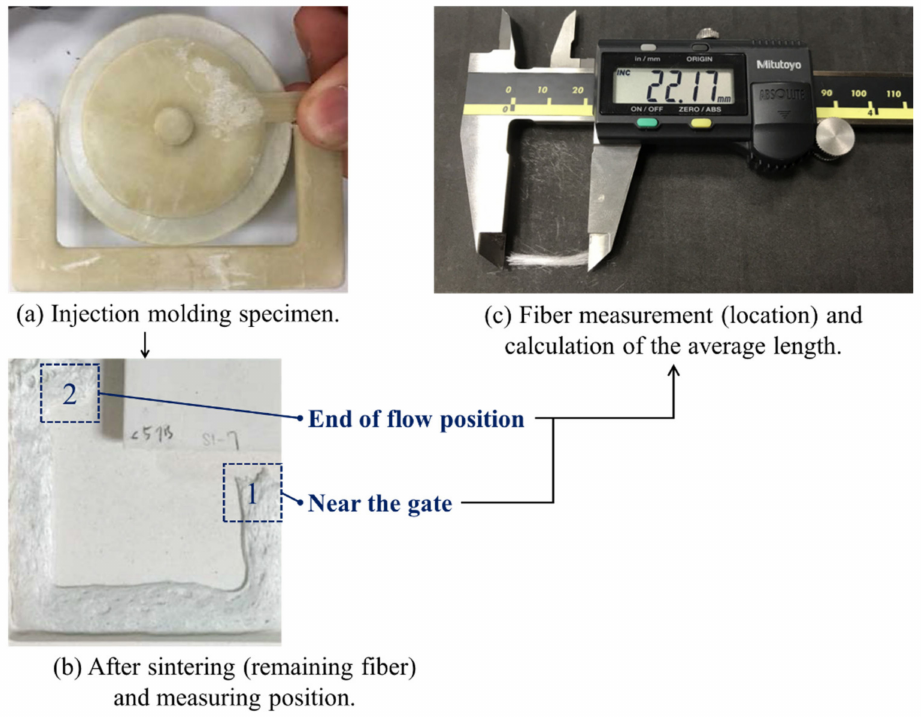
Figure 3. Schematics of the measurement position of the fiber length after breaking and the calculation of the fiber proportion: ( a ) injection molding part, ( b ) specimens were high-temperature sintering and leaving only the fibers that could then be measured, and ( c ) measurement fiber